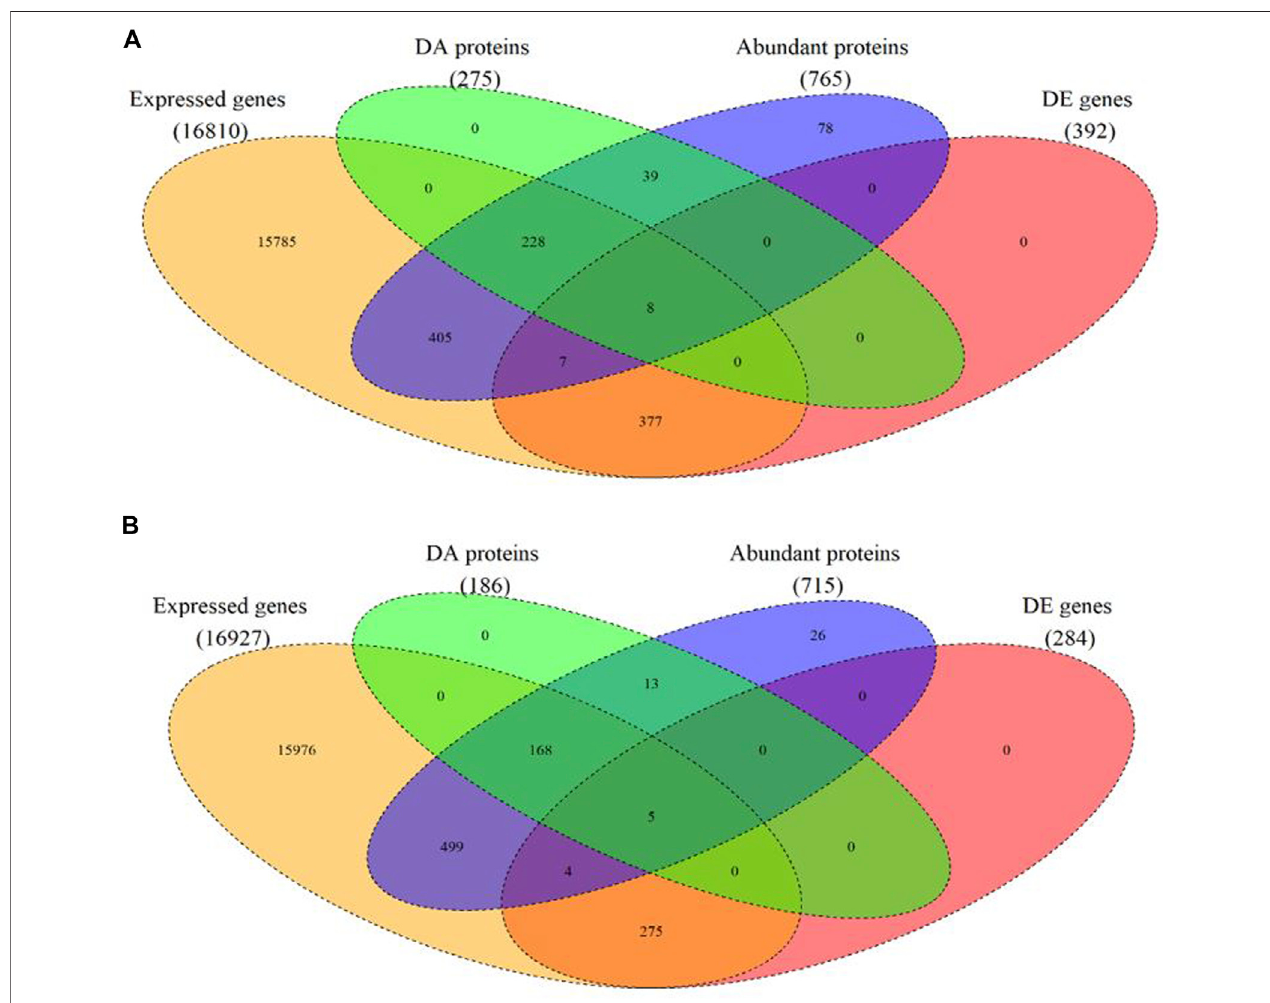
FIGURE 1 | Venn diagram of expressed mRNAs and proteins as well as differentially expressed (DE) mRNA and differentially abundant (DA) protein in each tissue. (A) in the hypothalamus tissue, (B) in the pituitary gland.